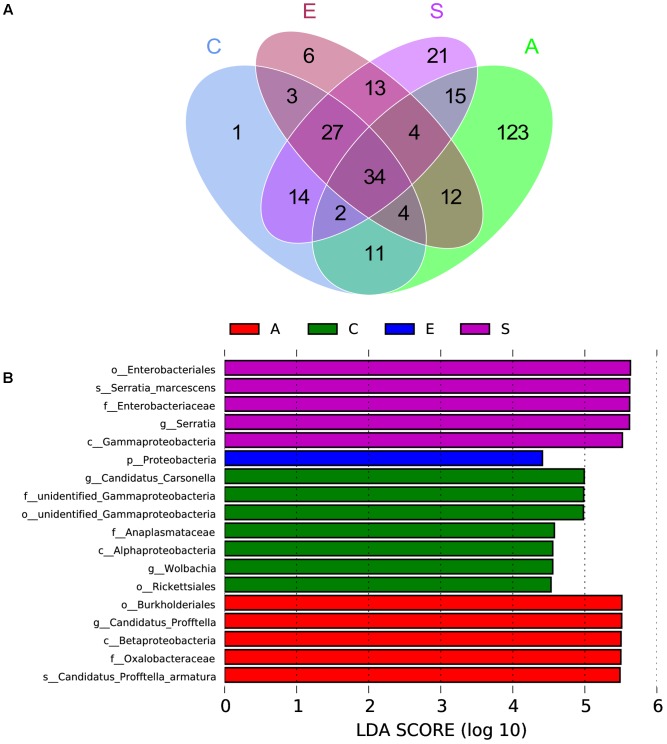
The scalar-Venn representation of shared genera among microbiome in groups C, A, E, and S (A) and the taxonomic representation of statistically significant differences among groups C, A, E, and S (B). C, PBS group; A, Fermentation product of S. marcescens KH-001 group; E, E. coli DH5α group; S, S. marcescens KH-001 group.